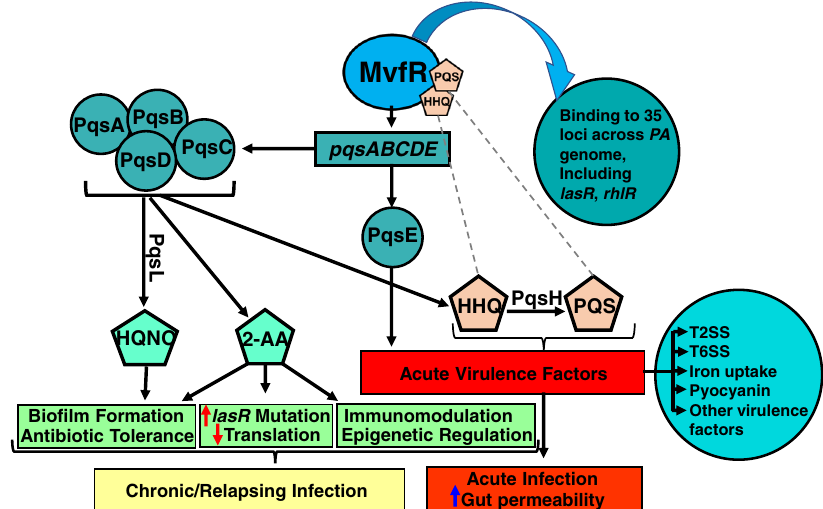
Fig. 1 | Current view of the P. aeruginosa MvfR QS system impact on acute and chronic functions. MvfR (PqsR), in the presence of its ligands/inducers PQS or HHQ, binds and activates the transcription of the pqs operon, whose encoded proteins catalyze the biosynthesis of ∼ 60 low molecular weight molecules, including HHQ, HQNO, and 2-AA. HHQ in turn is converted to PQS via PqsH.HQNOpromotespro-acute andpro-persistentphenotypes,whileHHQand PQS promote acute phenotypes. 2-AA ’ s immunomodulatory action and epige- netic regulation and its ability to promote the accumulation of lasR mutants